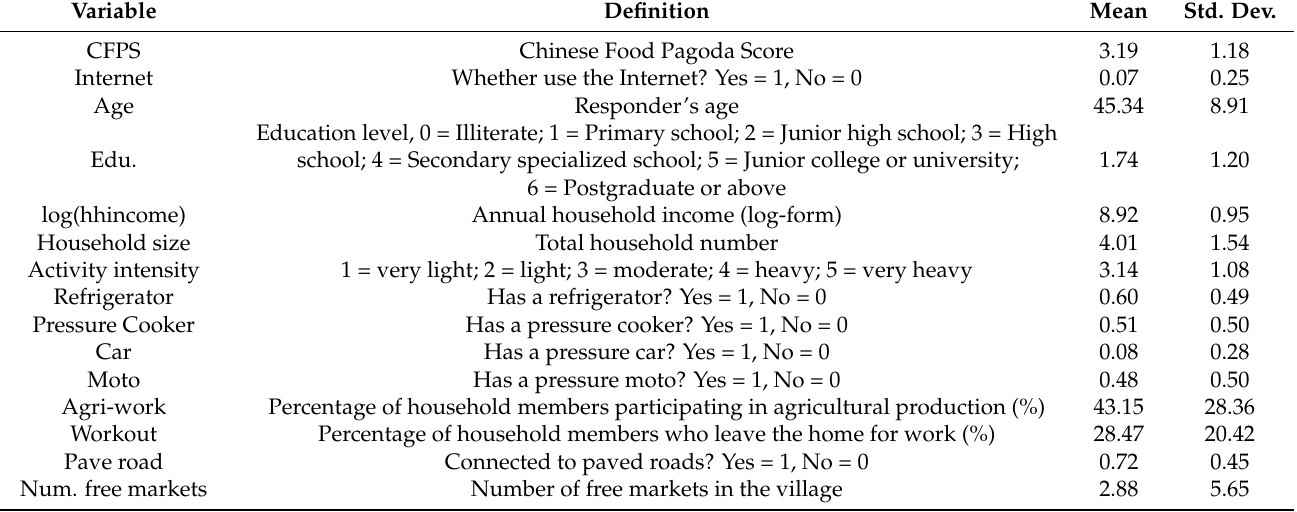
Table 1. Descriptive statistics of the